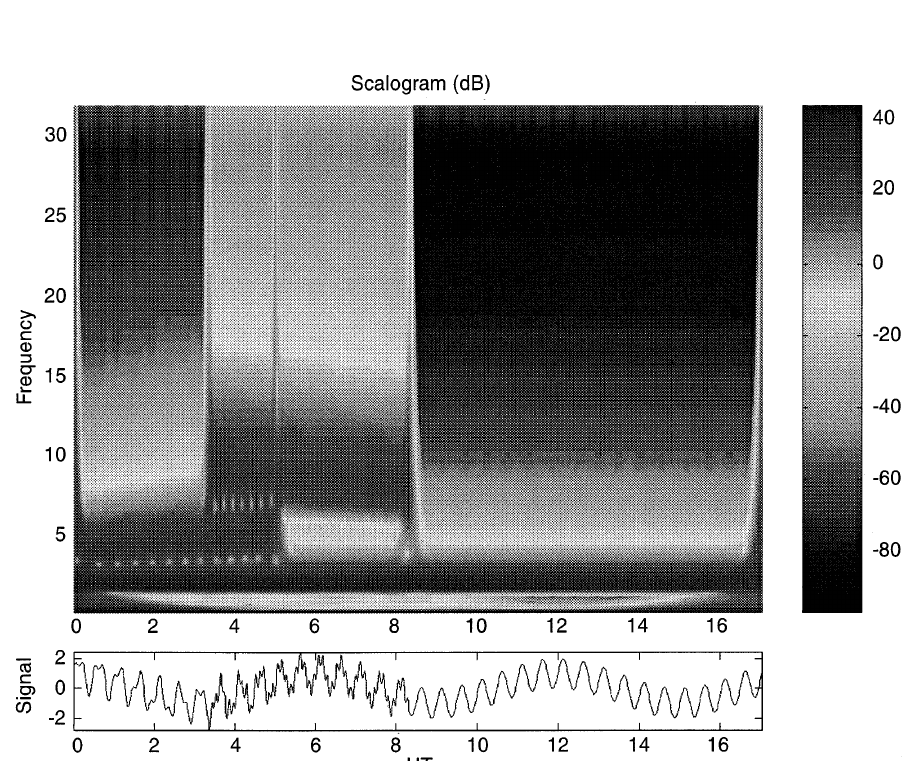
Fig. 4. Some dilated versions of the wavelet ( top , from left to right: a " 1/4,1,1/8) and their Fourier transform in modulus ( bottom , from left to right: a " 1,